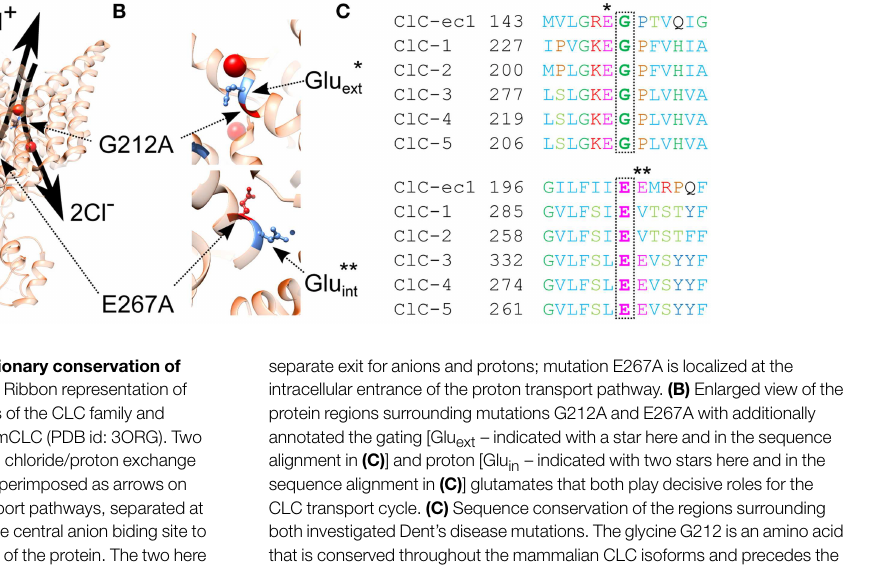
separate exit for anions and protons; mutation E267A is localized at the intracellular entrance of the proton transport pathway. (B) Enlarged view of the protein regions surrounding mutations G212A and E267A with additionally annotated the gating [Glu ext – indicated with a star here and in the sequence alignment in (C) ] and proton [Glu in – indicated with two stars here and in the sequence alignment in (C) ] glutamates that both play decisive roles for the CLC transport cycle. (C) Sequence conservation of the regions surrounding bothinvestigatedDent’sdiseasemutations.TheglycineG212isanaminoacid that is conserved throughout the mammalian CLC isoforms and precedes the gatingglutamate Glu ext .Glutamate E267isalsowell-conservedandprecedes the proton glutamate E268 in the sequence of